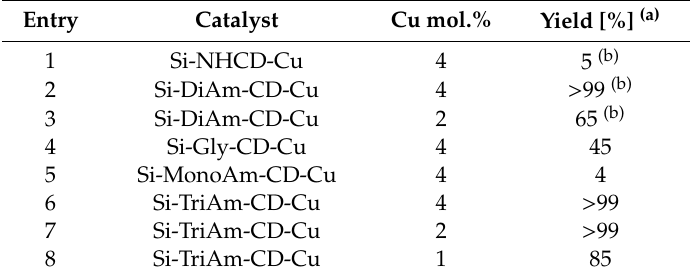
Scheme 2. Model reaction for CuAAC of Si-Linker-CD-Cu. Table 2. Panel test of CuAAC reaction.